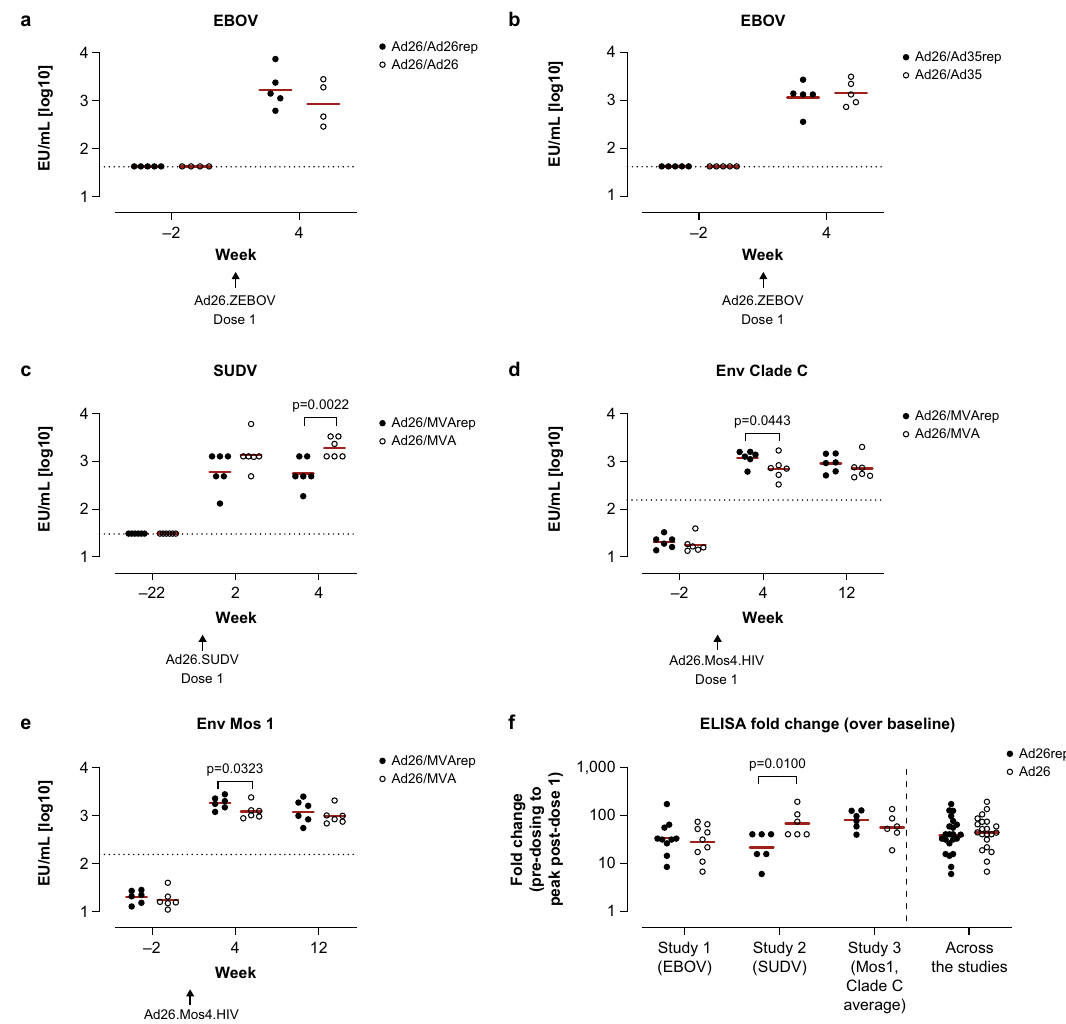
Fig. 4 Ad26 vaccine – elicited vector-immunity has a minor impact on humoral immune responses induced by a fi rst dose of the B-series in cynomolgus macaques. Binding serum antibody concentrations were measured by ELISA for each regimen speci fi c for EBOV glycoprotein (GP) ( a , b ), SUDV GP ( c ), HIV Env Clade C ( d ), and HIV Env Mos1 ( e ). Shown are geometric group means of the log10 EU/mL values determined relative to an assay standard. Dotted lines represent the LLoD/LLoQ. For ( a , b ), the LLoQ of the human assay of 1.62log10 was used. For ( c ), the LLoD was de fi ned as 1.48log10 (EU/mL), which was measured for the pre-dosing samples in the SUDV GP – speci fi c assay 36 . For ( d , e ), the LLoQ of the human assay of 2.19log10 was used, whereas the ULoQ of the human assay was 3.69log10 31 . The fold-change in antibody concentrations is depicted in ( f ) and corresponds to the change in response comparing pre – dose 1 to peak response post – dose 1 per animal. “ Ad26rep ” refers to animals vaccinated in the A-series, and “ Ad26 ” refers to animals that were not vaccinated during the A-series. Pairwise comparison of the difference between pre-exposed animals and unexposed animals per time point was performed for data in ( a – e ), summarized in Supplementary Table 2. An ANOVA was performed over the fold-changes per study and across the 3 studies over the data shown in ( f ), summarized in Supplementary Table SUDV-speci fi c IFN γ -producing cells over time in the Ad26- unexposed compared to pre-exposed animals receiving the unexposed group was observed. A similar increase was not heterologous Ad26/Ad35 regimen, which was most pronounced observed in the animals with pre-existing immunity to Ad26 and at week 10 and week 12 (week 10: p = 0.0016; week 12: MVA, although the difference between the pre-exposed and p = 0.0011; Tobit model; Supplementary Table 1), but not for the unexposed animals did not reach statistical signi fi cance (Fig. 5c, homologous Ad26/Ad26 regimen (Fig. 5a, b). There was a Supplementary Table 2). Furthermore, there was no clear comparable fold-increase in EBOV GP – speci fi c IFN γ ELISpot difference in the relative fold-change of the peak response responses above pre-boosting levels following a second (homo- between pre-exposed and unexposed animals ( p = 0.2793; logous) dose of Ad26.ZEBOV at week 8 in animals with and ANOVA; Fig. 5e, Supplementary Table 3). without pre-existing Ad26 immunity (Fig. 5e, Supplementary Table In study 3, in which animals were dosed with Ad26.Mos4.HIV/ 3). MVA-mBN414A (Ad26/MVA rep group), higher levels of the For the heterologous Ad26/MVA schedule (study 2), the individual, absolute Env-, Gag-, and Pol-speci fi c IFN γ ELISpot magnitude of SUDV-speci fi c IFN γ -producing cells after MVA-BN- responses were induced in pre-exposed versus unexposed Filo dosage at week 9 was comparable for animals pre-exposed to animals after the second dose, which reached statistical Ad26 and unexposed, and thereafter a trend for an increase of